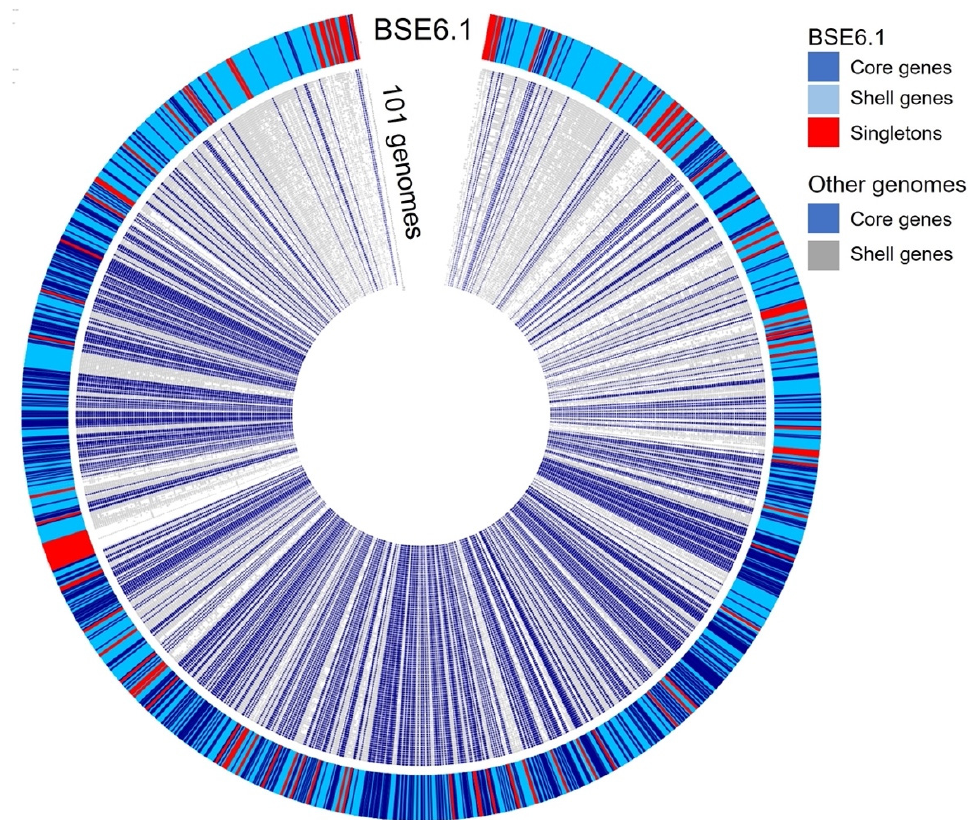
Figure 6. Pangenome comparison of strain BSE6.1 and 101 related genomes (Sup. Data 4) of Streptomycetaceae family. The genome of strain BSE6.1 has 12.6% of conserved genes, 84.1% of shared or shell genes, and 3.3% of unique genes.